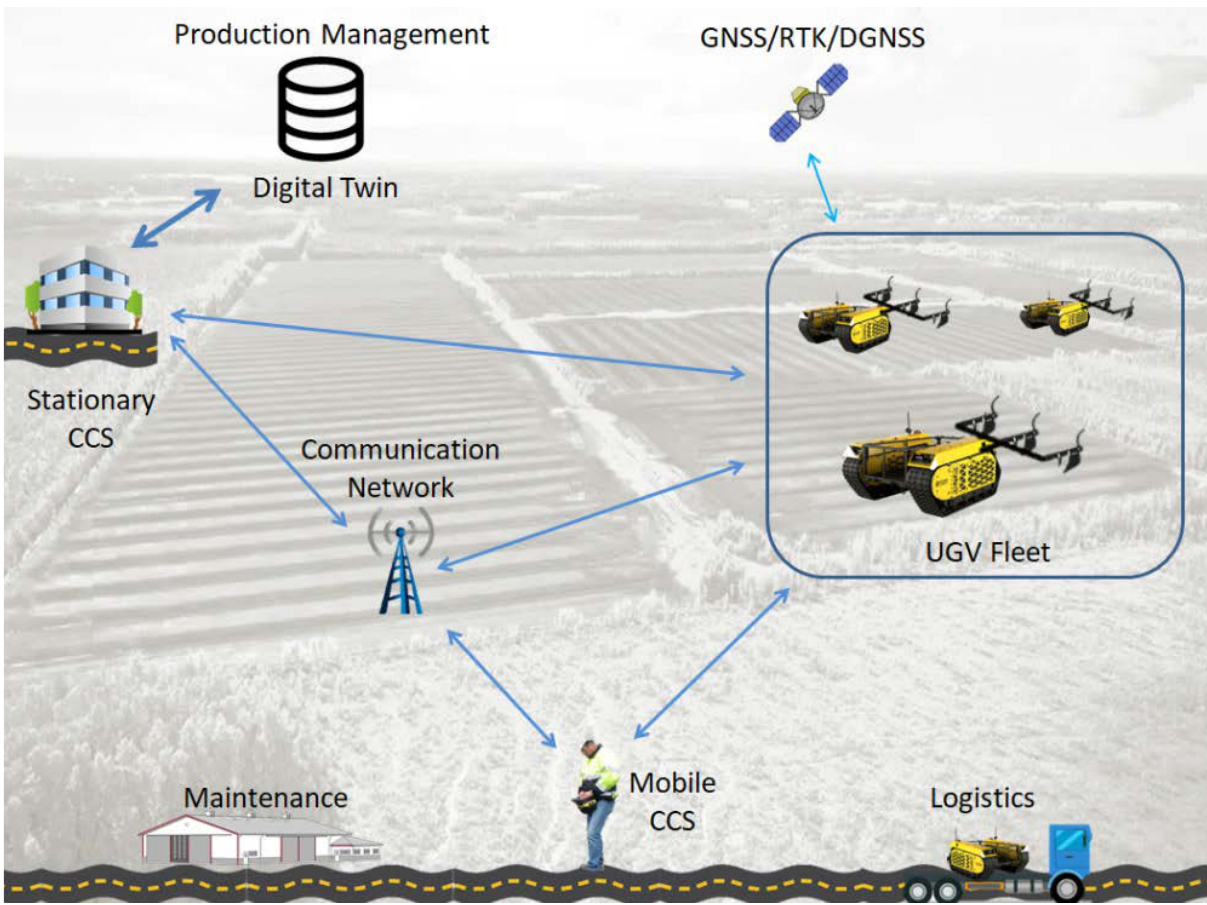
Figure 4. The robotic milled peat extraction solution